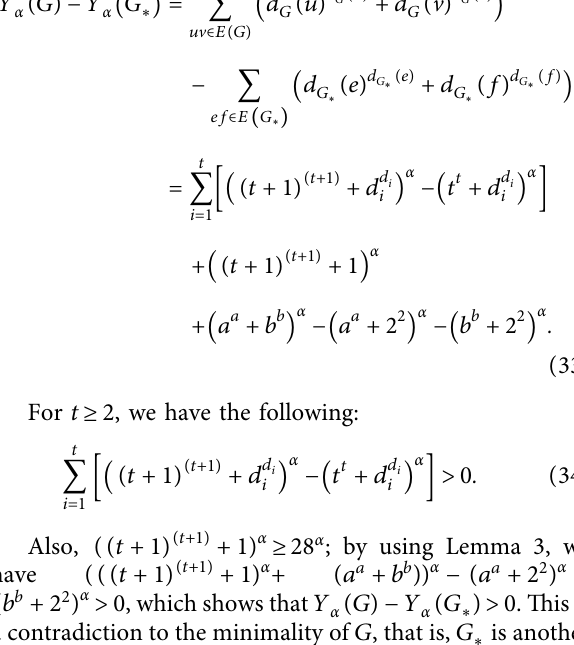
Comparison of 8 α +4 (260) α and 4 (31) α +(54) α